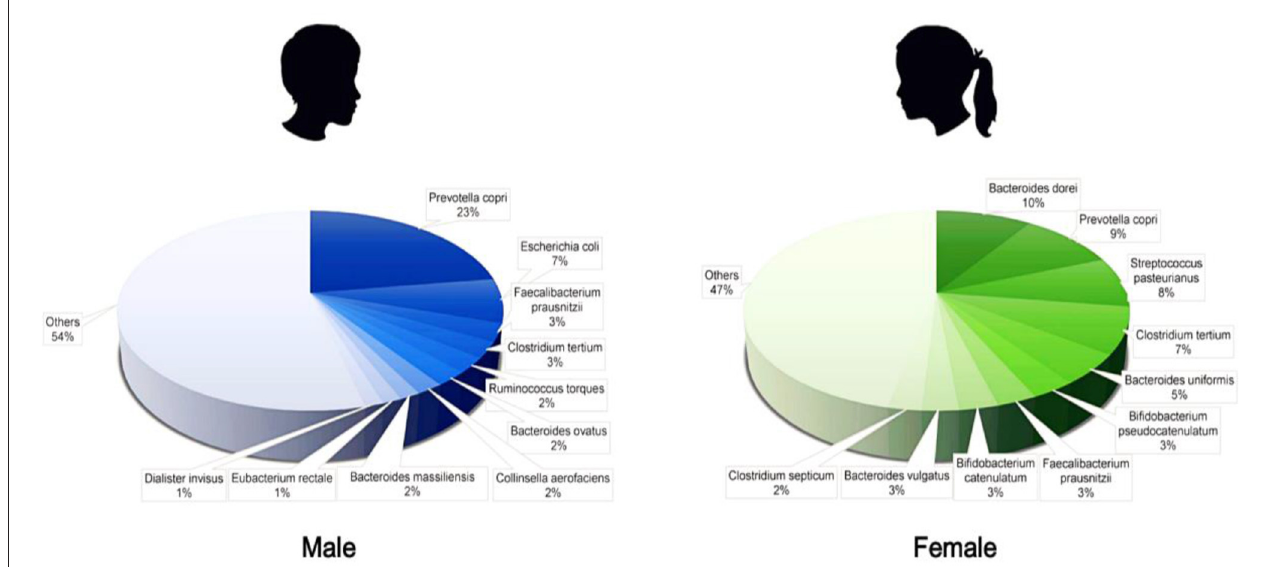
FIGURE 6 | Difference of intestinal microbiota abundance between male and female.